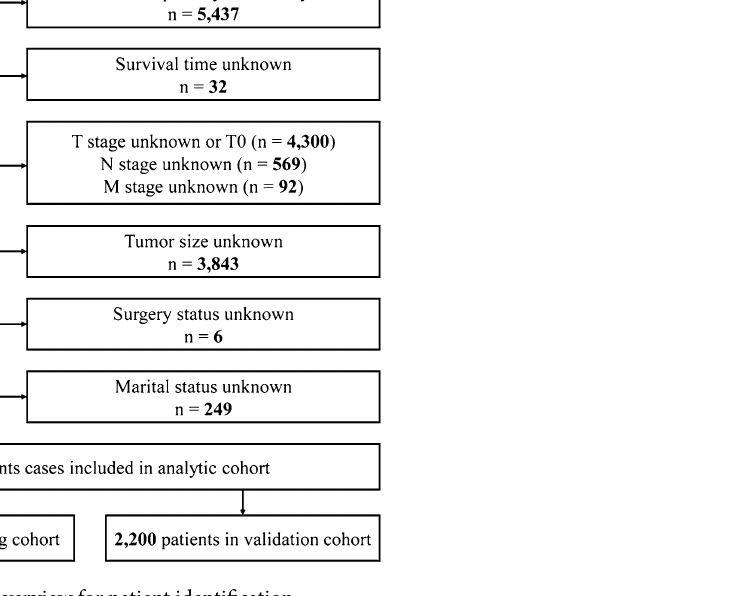
Figure 1. Schematic overview for patient